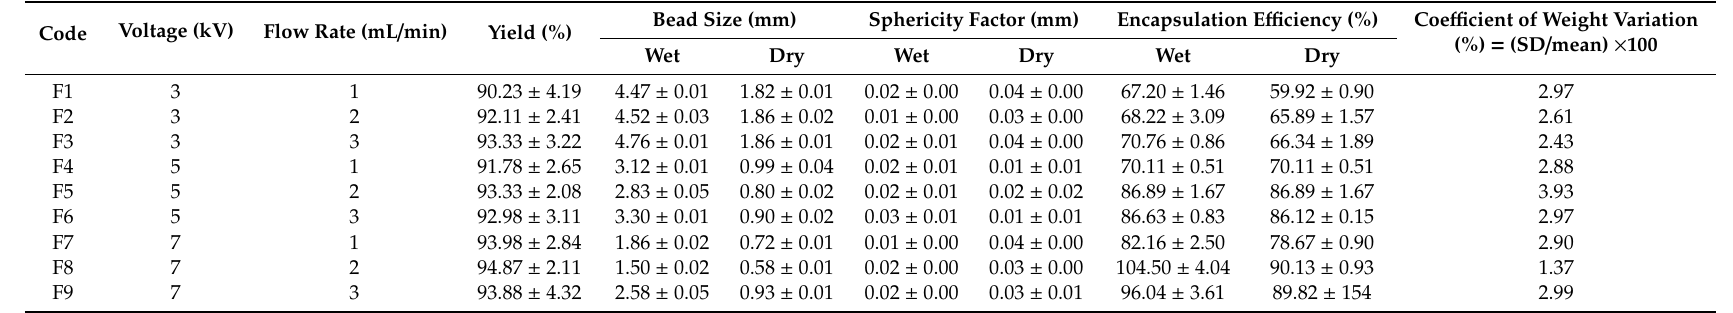
Table 2. E ff ect of voltage (kV) and flow rate (mL / min) on bead size, sphericity factor and encapsulation e ffi ciency ( n = 3, mean ± SD).